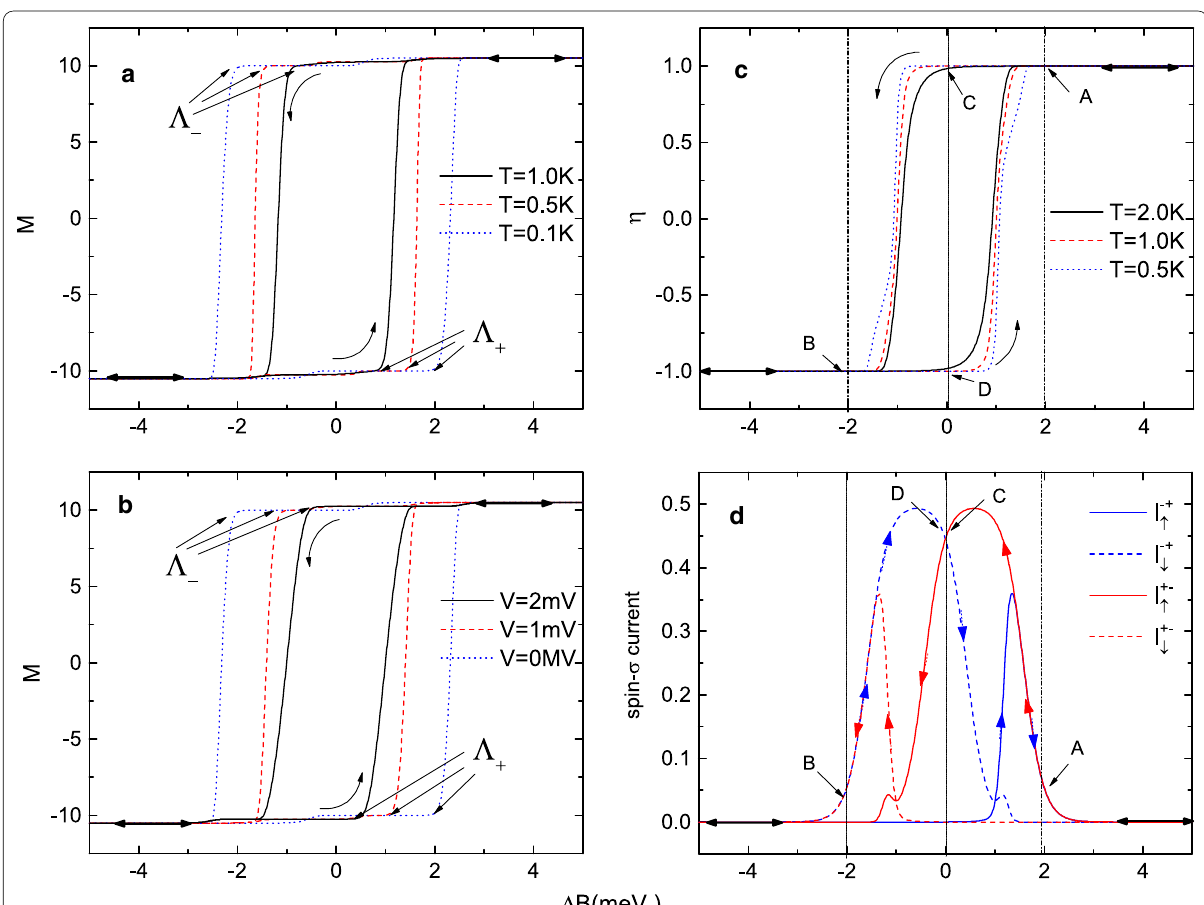
Fig. 2 a , b Magnetic hysteresis loops of the SMM for a different equilibrium temperatures and b different bias voltages when the external magnetic field (cid:31) B is scanned back and forth. c Spin polarization of the tunneling current for different equilibrium temperatures and d spin- σ currents (scaled by e Ŵ 0 / (cid:31) ) at T = 0.5 K when the external magnetic field (cid:31) B is scanned back and forth under a fixed bias of V = 1